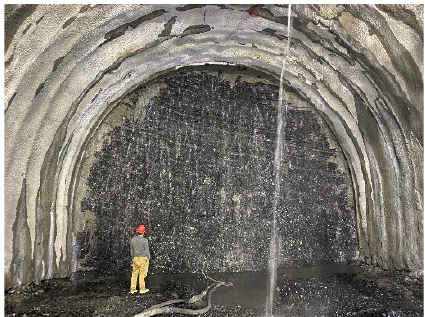
Figure 6. Tunnel excavation face at the K78+350 section.